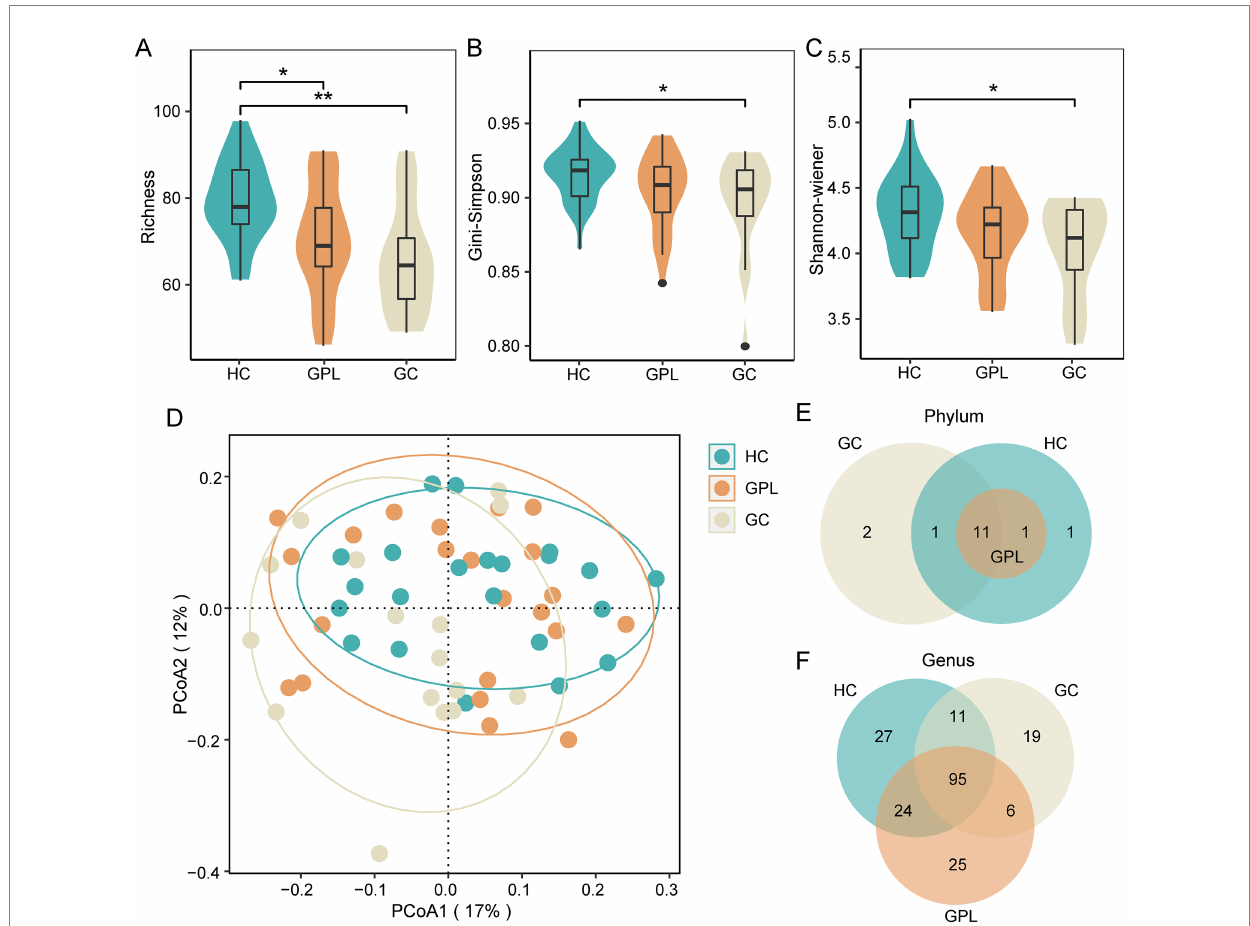
FIGURE 1 The microbial diversity of microbial communities. Alpha diversity index analysis richness (A) , Gini-Simpson (B) , and shannon-wiener (C) (kruskal – wallis test, * p < 0.05, ** p < 0.01). (D) Beta diversity PCoA analysis (ANOSIM R = 0.077, p < 0.05), the ellipse contains 85% of the samples in each group. The difference of composition in phylum (E) , genus (F) level between three groups. HC, healthy control; GPL, gastric precancerous lesions; GC, gastric